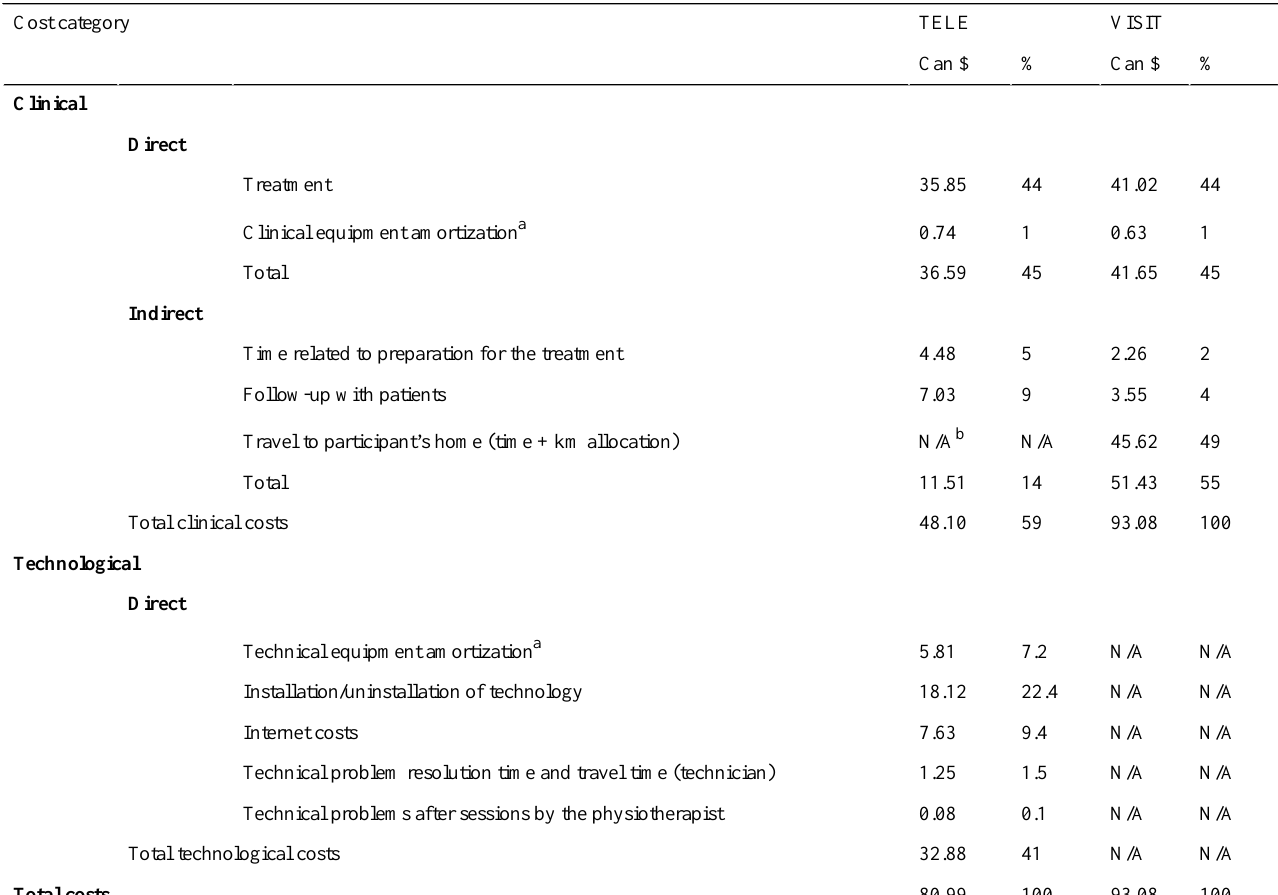
Table 4. Breakdown of costs per treatment (telerehabilitation and home visits).